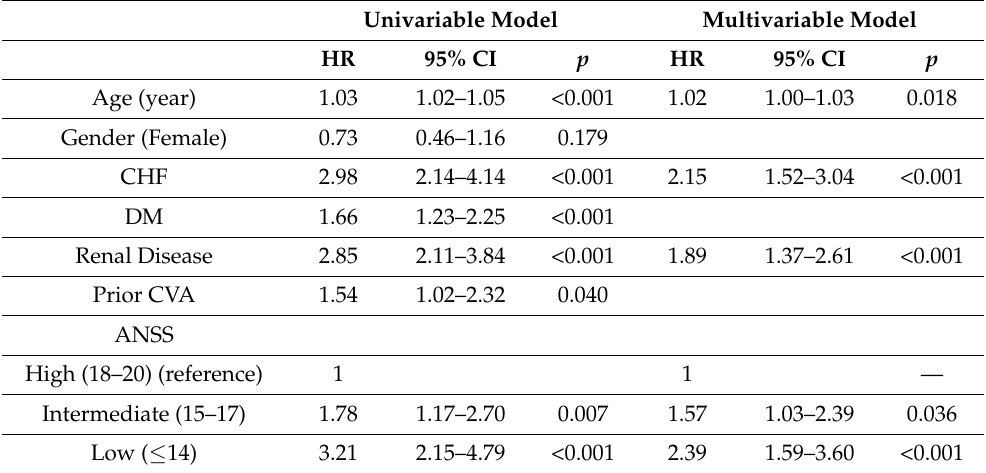
Table 2. COX proportional hazards univariable and multivariable models for all-cause mortality.